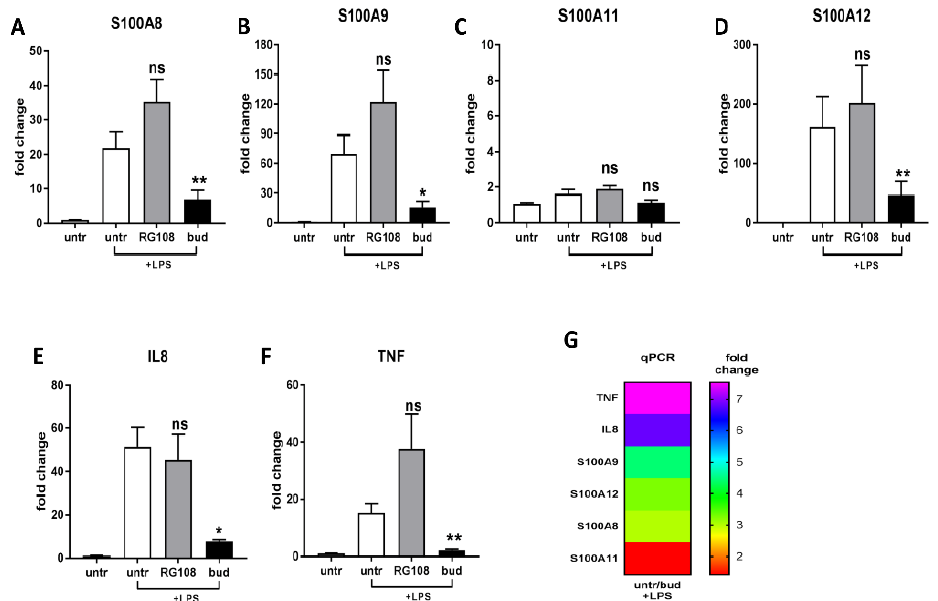
Figure 2. Comparison of the expression of selected genes in untreated THP-1 cells and those treated with budesonide or RG108 in the presence of LPS: The expression levels of S100A8 ( A ), A100A9 ( B ), S100A11 ( C ), S100A12 ( D ), IL-8 ( E ), and TNF ( F ) genes treated with budesonide or RG108 in the presence of LPS following 48 h incubation in THP-1 cells ( n = 6). Heatmap of fold change in TNF, IL-8, S100A9, A100A12, S100A8, and S100A11 expression levels between untreated THP-1 cells and those treated with budesonide + LPS following 48 h of incubation, measured by qRT-PCR ( n = 6) ( G ). p values were expressed as follows: 0.05 > p > 0.01 as *, 0.01 > p > 0.001 as ** and ns — not signif-